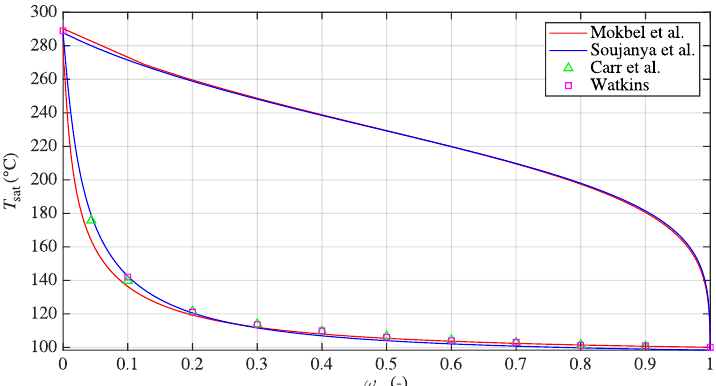
Figure 1. Phase diagram of water–glycerin mixture near atmospheric pressure calculated with models of Mokbel et al. [16] and Soujanya et al. [17] and compared with experimental results of Carr et al. [21] and Watkins [20].